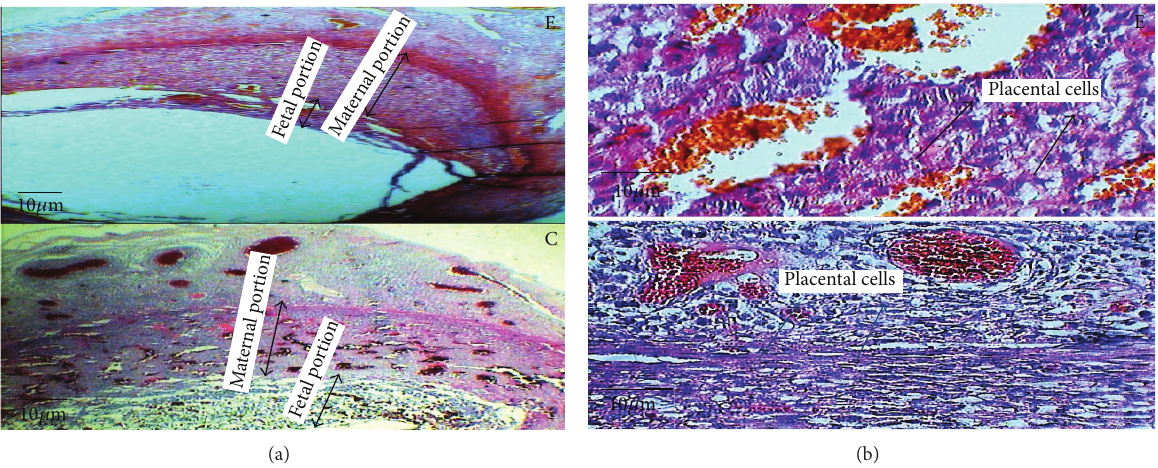
Figure 6: The microscopic image of the time-dependent effect of oral morphine consumption in the experimental (E) groups and the control (C) groups in the 10-day-old placenta with 40x magnification, (a) illustrating the thicknesses of both maternal and fetal portions of the placenta by the double-headed arrow. (b) The microscopic image of the experimental group and the control group in the 10-day-old placenta with 40x magnification, illustrating the placental